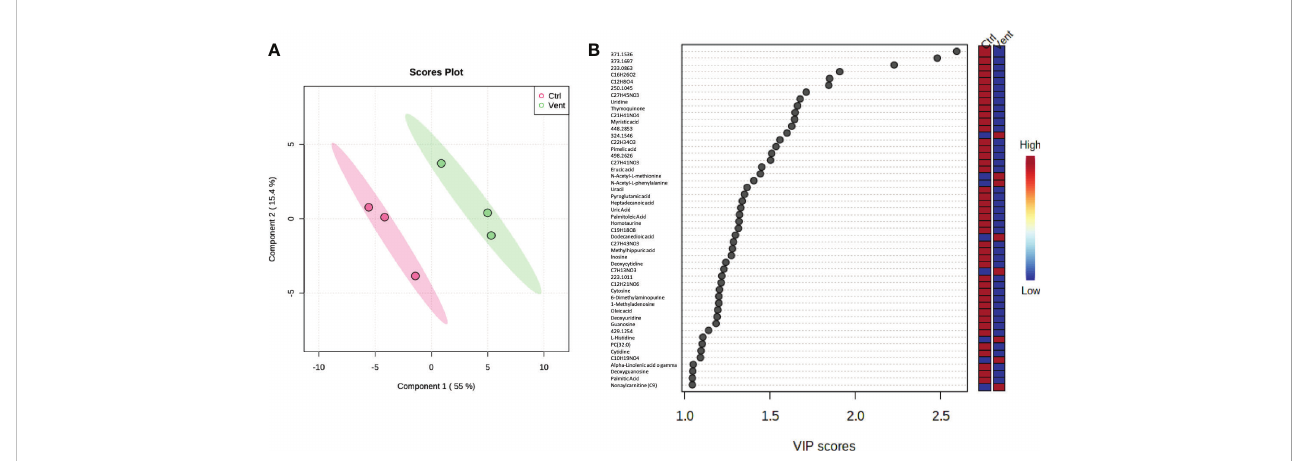
FIGURE 3 Scores plot between the selected PCs (A) , the explained variances are shown in brackets. Important features identi fi ed by PLS-DA (B) . The colored boxes on the right indicate the relative concentrations of the corresponding metabolite in each